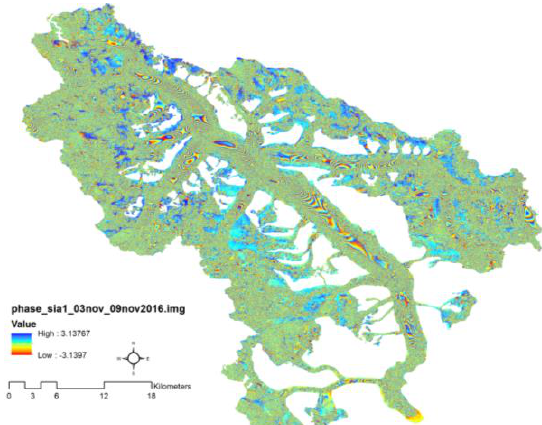
Figure 8: Phase map of Siachen glacier